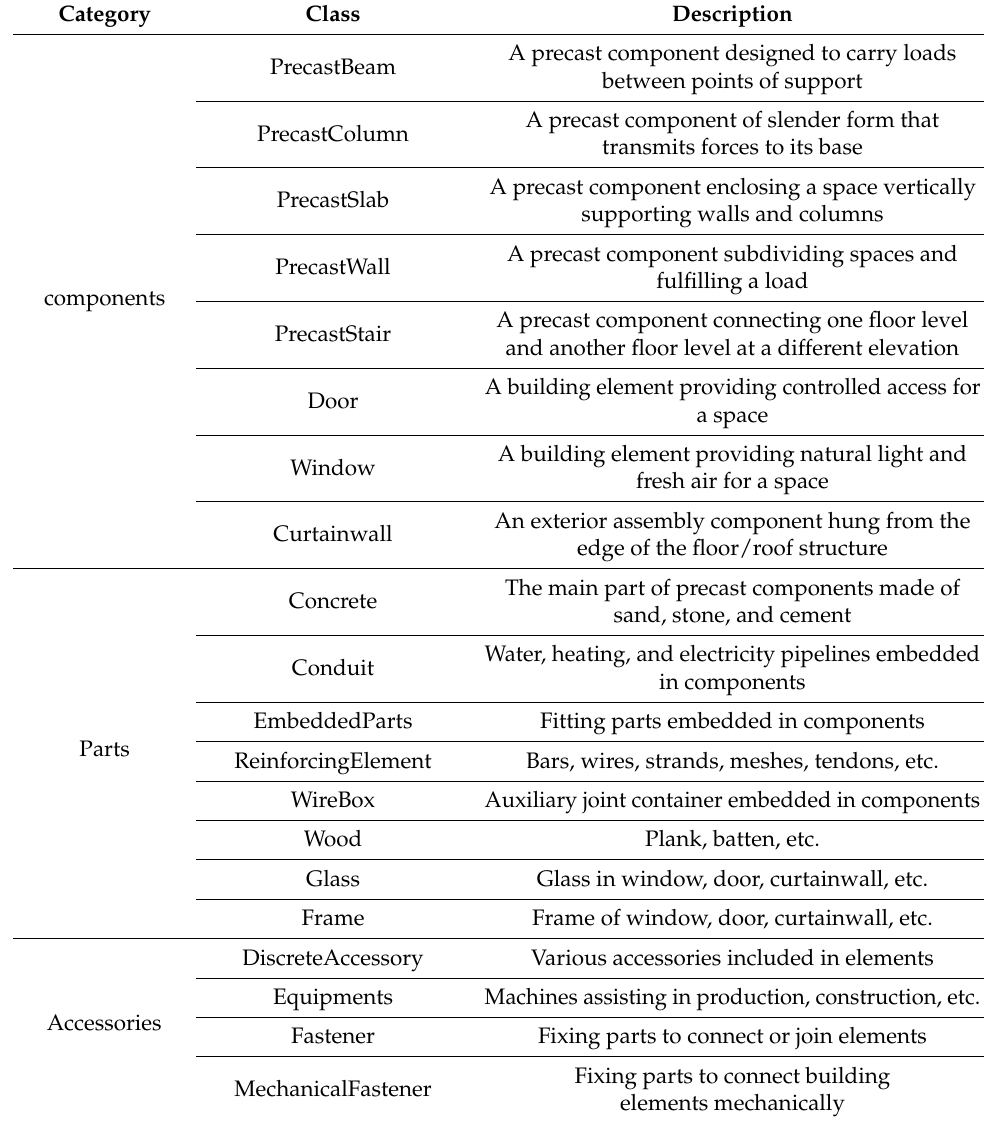
Table 1. Definition of assembly knowledge base